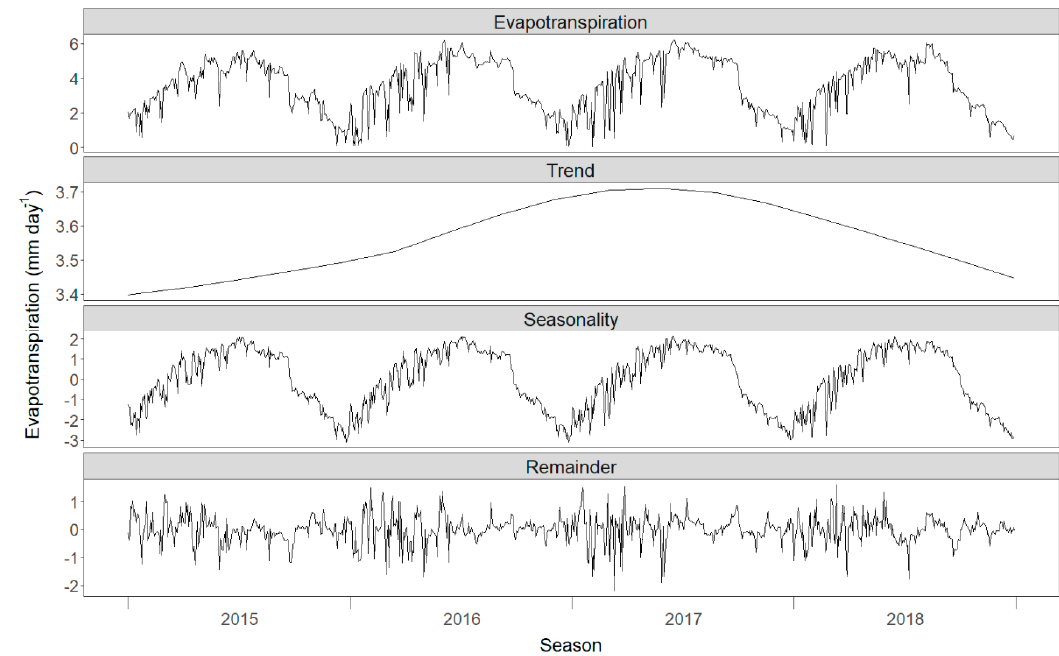
Figure A1. Illustration of time-series decomposition for a specific pixel within the vineyard.